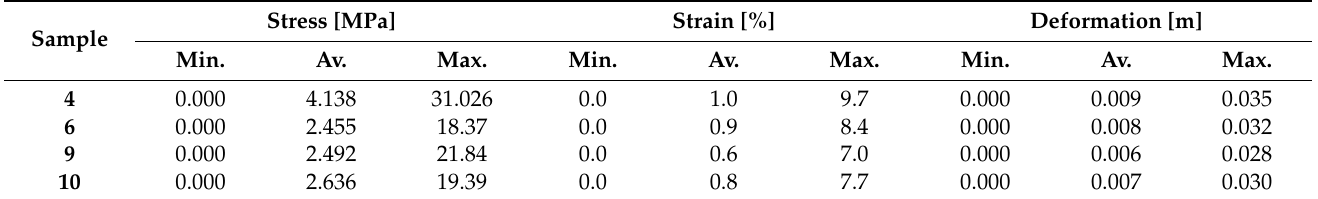
Table 6. The minimum, average, and maximum values of stress, strain, and deformation of the considered